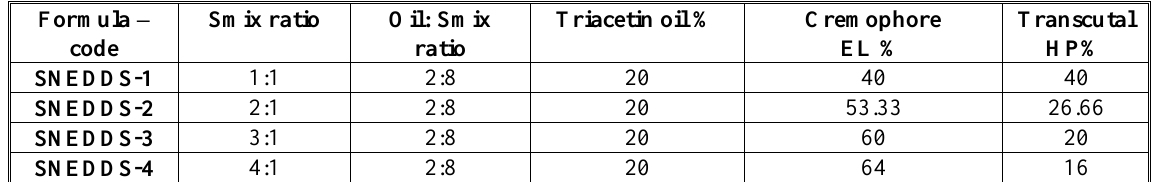
Table 1. Composition of piroxicam liquid SNEDDS (% w/w) Formula